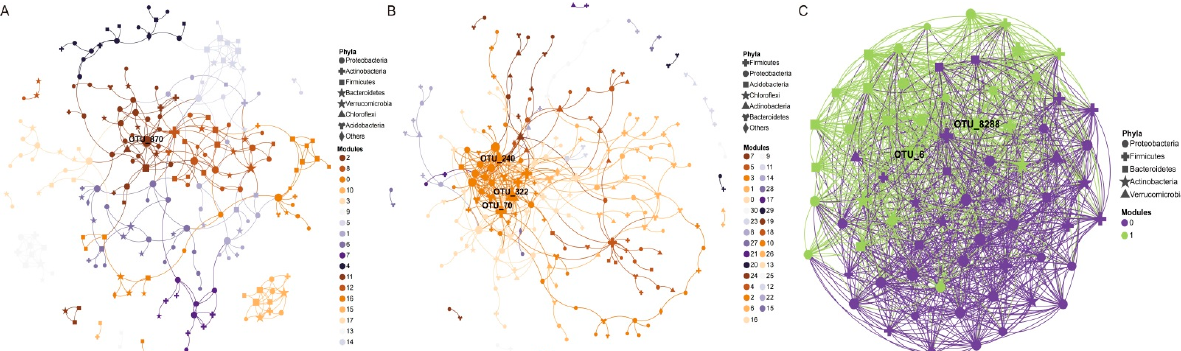
Figure 3. ( A ) Co ‐ occurrence network of the whole dataset based on correlation analysis; ( B ) co ‐ occurrence network of the CRT dataset based on correlation analysis; ( C ) co ‐ occurrence network of the CRAT dataset based on correlation analysis. The size of each node is proportional to the number of connections (that is, degree). OTUs colored according to different modules. The shape of OTUs shows the taxonomy at the phylum level.